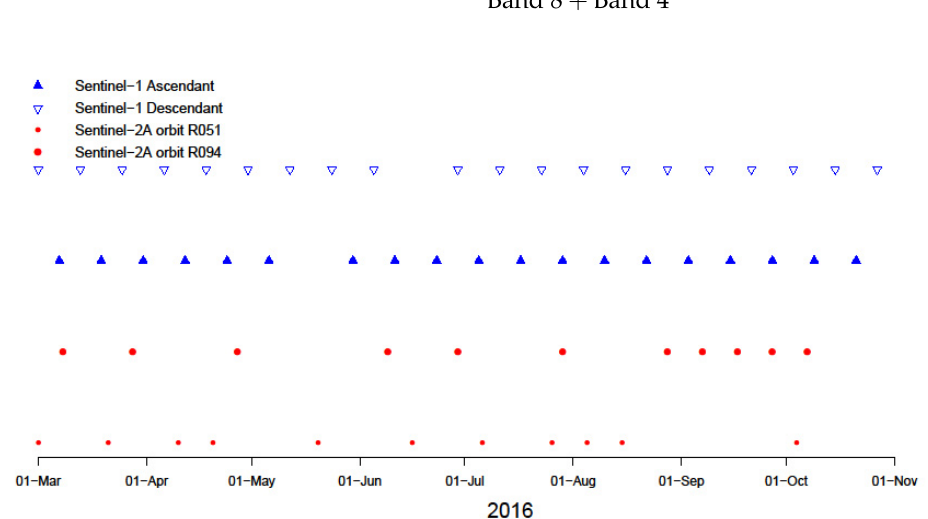
Figure 2. Acquisition dates of Sentinel-2A and Sentinel-1 data.